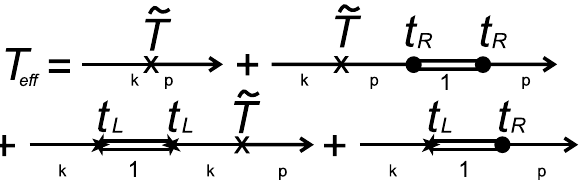
Figure 5. (Color online) Diagrams contributing to the effective tunneling transfer amplitude T eff considering multiple electrons returns from intermediate site to one of the contact